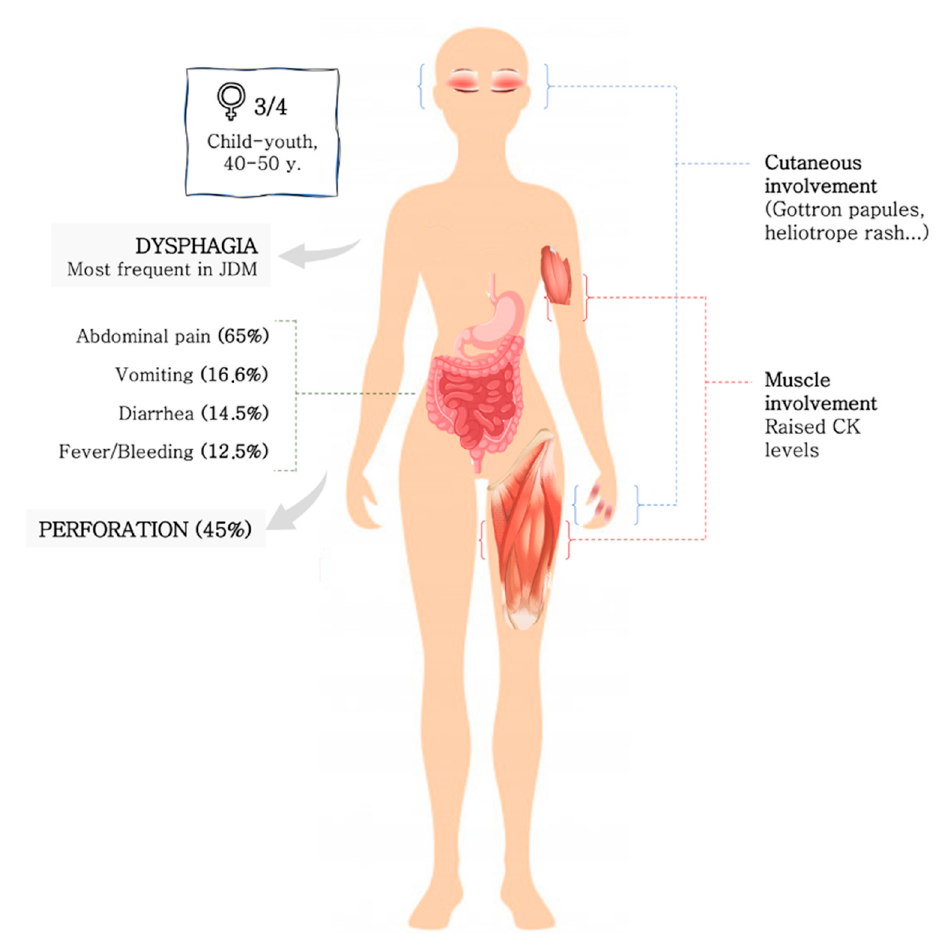
Figure 3. Clinical-epidemiological features of GI involvement in DM.